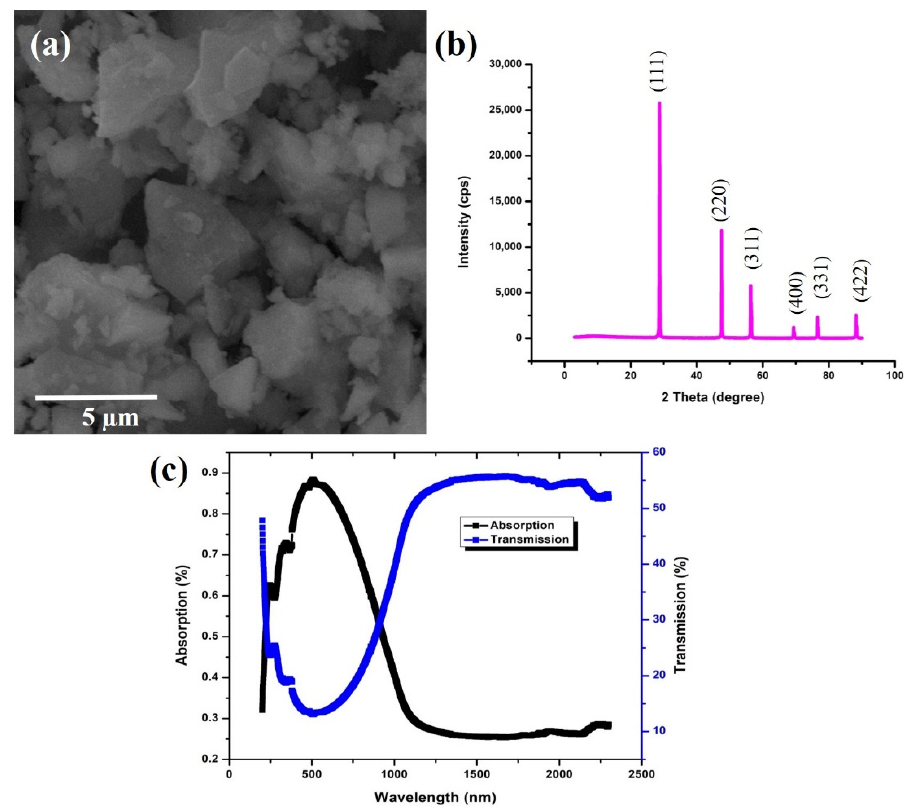
Figure 5. ( a ) SEM micrograph, ( b ) XRD pattern, and ( c ) UV-vis spectra of the as-received Si pow-